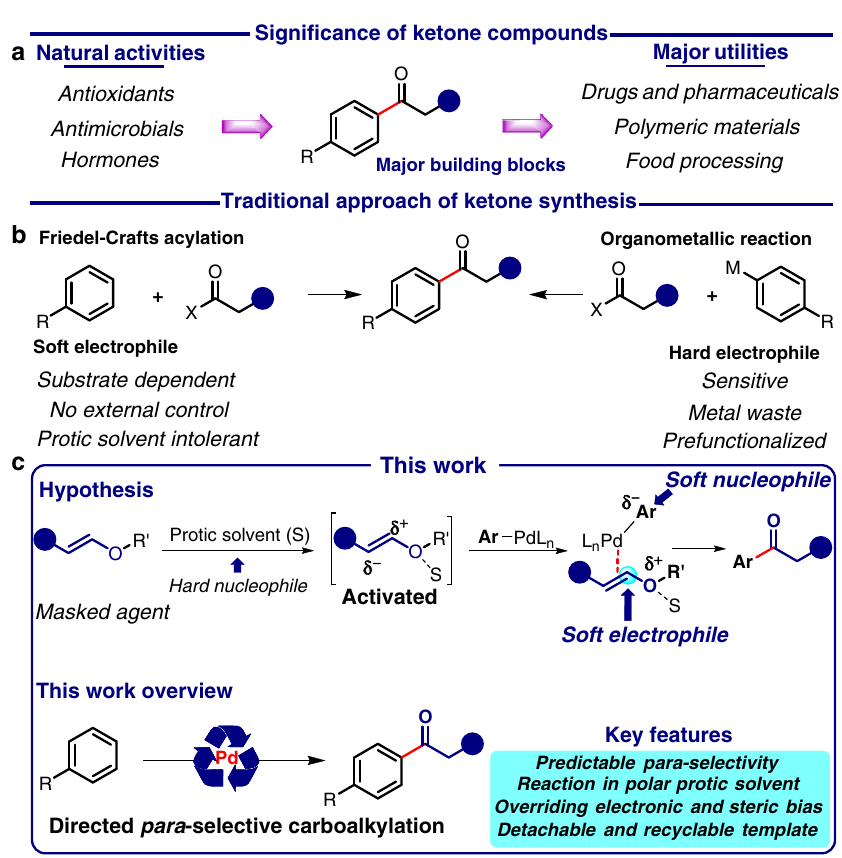
Fig. 1 Overview of the work. a Diverse functions of ketones. b Classic synthetic routes for ketone synthesis and its drawbacks. c Mechanistic hypothesis for generalised approach and key outline of the